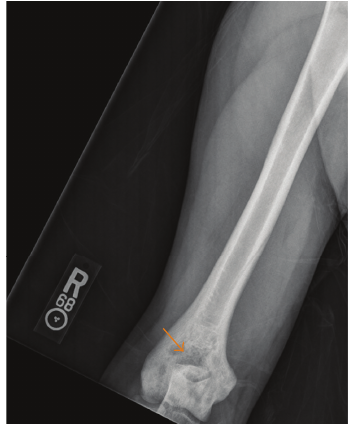
Figure 2: A 35-year-old male with frontal radiograph of the distal right humerus: there is mixed sclerosis and lucency in the distal metaphysis and epiphysis (arrow). Similar findings were present on the contralateral